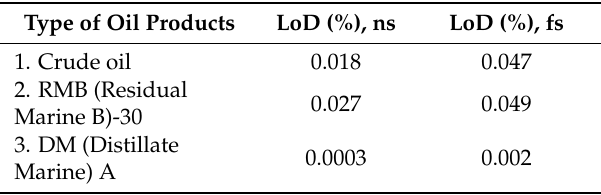
Table 1. LoD values with different concentrations of oil